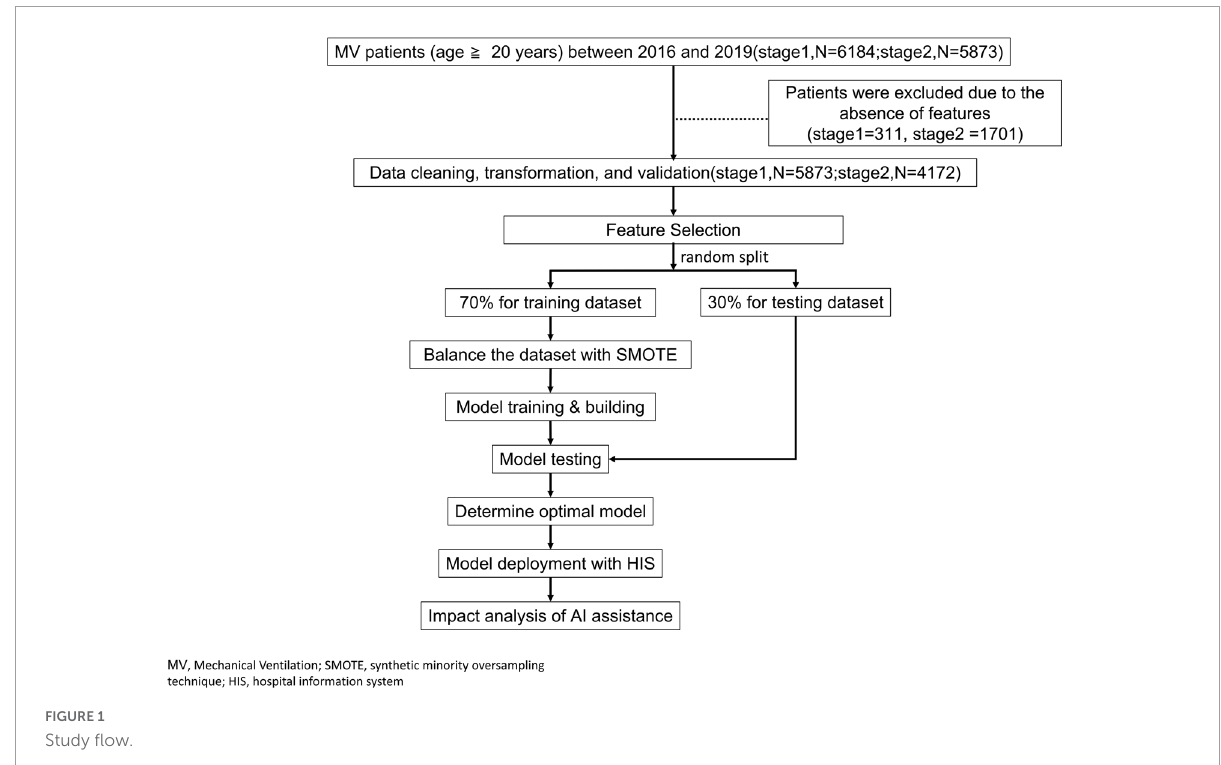
FIGURE1 Study flow.